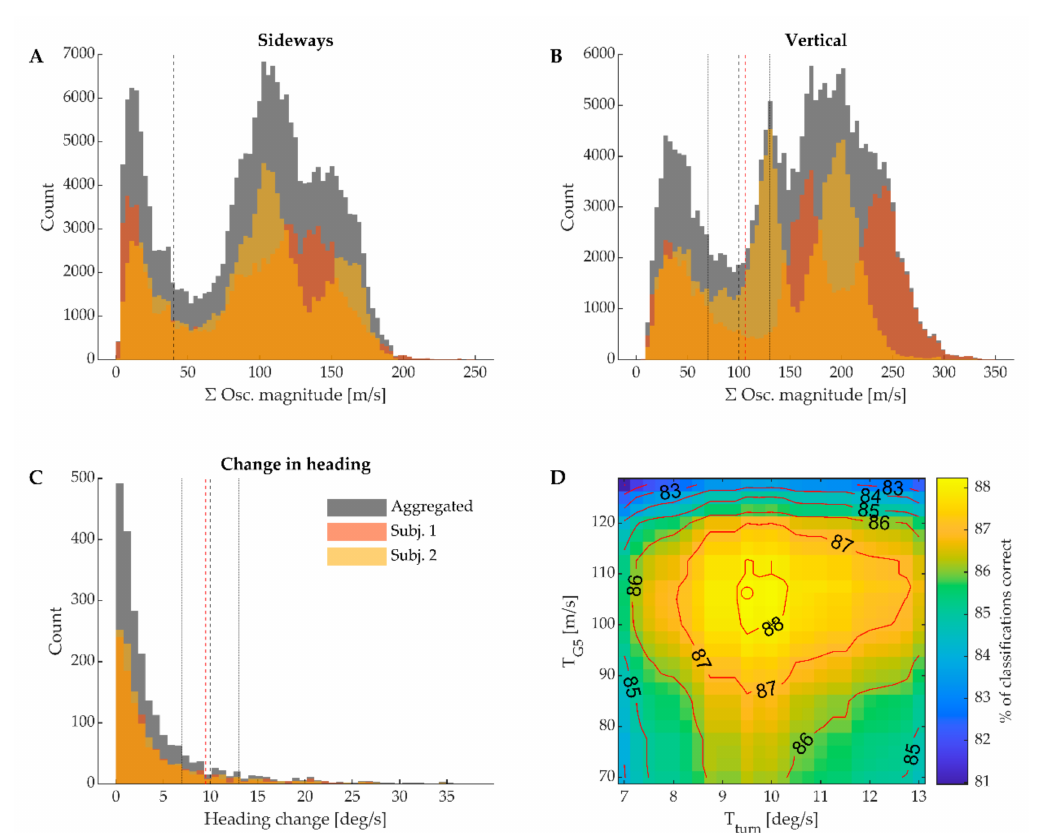
Figure 8. Top row: Histograms showing the distributions the summed frequency magnitudes of the head’s velocity in the sideways (panel ( A ), frequencies between 0.5–1.0 Hz) and vertical (panel ( B ), frequencies between 0.5–1.5 Hz) directions. ( C ) Histogram showing the distribution of change in skiing direction per technique cycle. In ( A – C ), yellow and red bars show the individual participants’ contributions to the aggregated distribution (gray bars), dashed black lines show the thresholds used in the hard decision rules classification, dotted lines (( B , C ) only) show the range that was explored in the numerical optimization, and the dashed red line shows the value maximizing the number of correct classifications. ( D ) Result of the numerical optimization of different thresholds ( T G5 and T turn ). The contour plot shows how the number of correctly classified cycles (sum of diagonal entries on the confusion matrix, Figure 6A) changed when T G5 and T turn varied. The number of correct classifications is presented as a percentage of the total number of detected cycles in the video-based validation. Changes in the threshold used in panel A could not be included in the same analysis because this would have changed the number of cycles detected with the automated algorithm, which would require a manual re-assessment of falsely detected and/or not detected cycles for each threshold